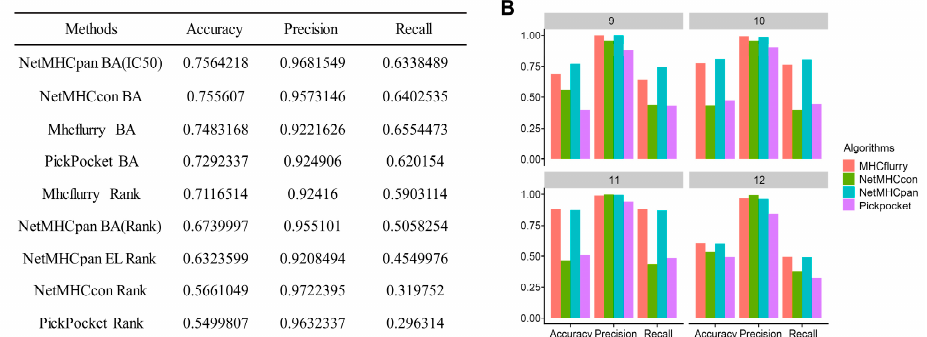
Figure 1. An overview of Seq2Neo. The input of Seq2Neo includes raw WGS, WES, RNA-seq or peptide information. Seq2Neo predicts various peptide features, including CNN-based immuno- genicity score, peptide–HLA binding affinity, TAP transport efficiency and gene expression. Then, Seq2Neo uses those features to rank candidate neoantigens.